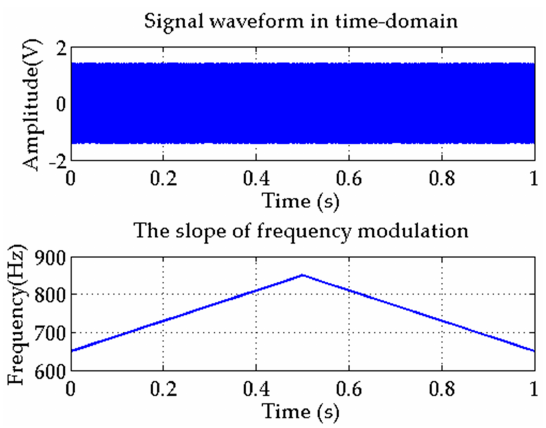
Figure 4. Detection signal waveform in time-domain and the slope of frequency modulation.